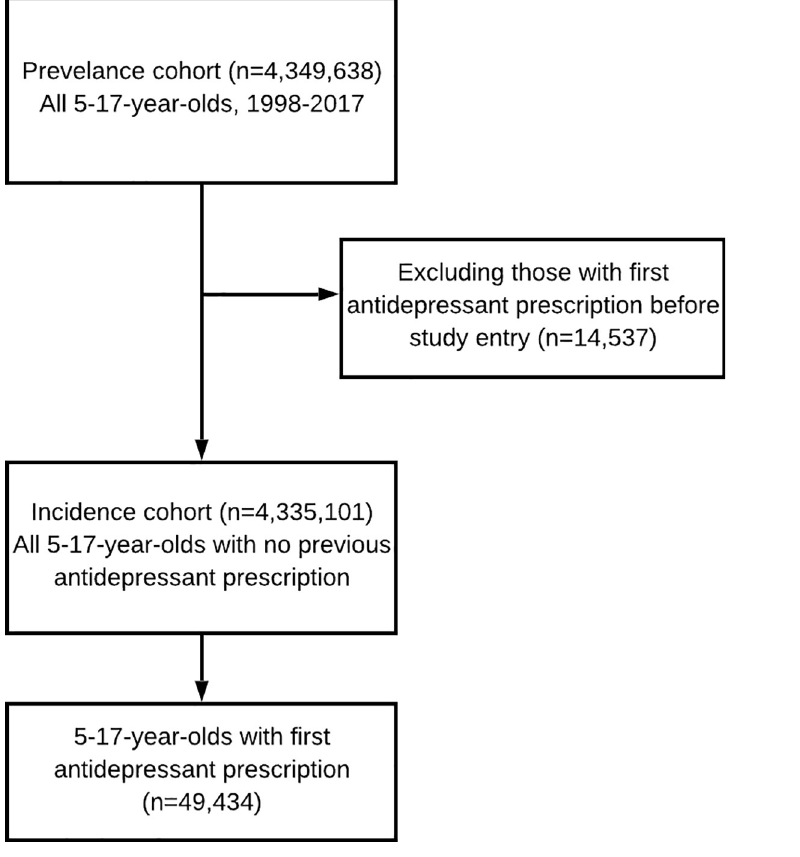
Fig 1. Flowchart of selection of study